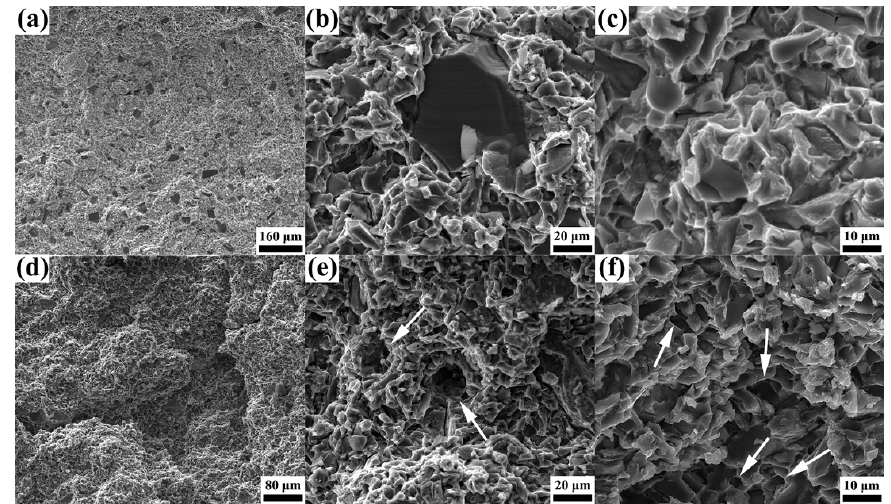
Figure 10. Representative tensile fracture morphologies of the composites: ( a – c ) Fracture surfaces of